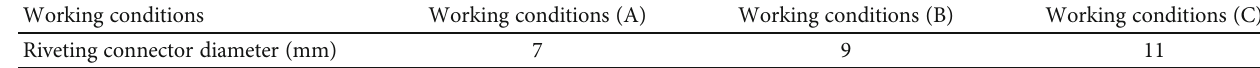
Table 5: Diameter working conditions of riveting joints.